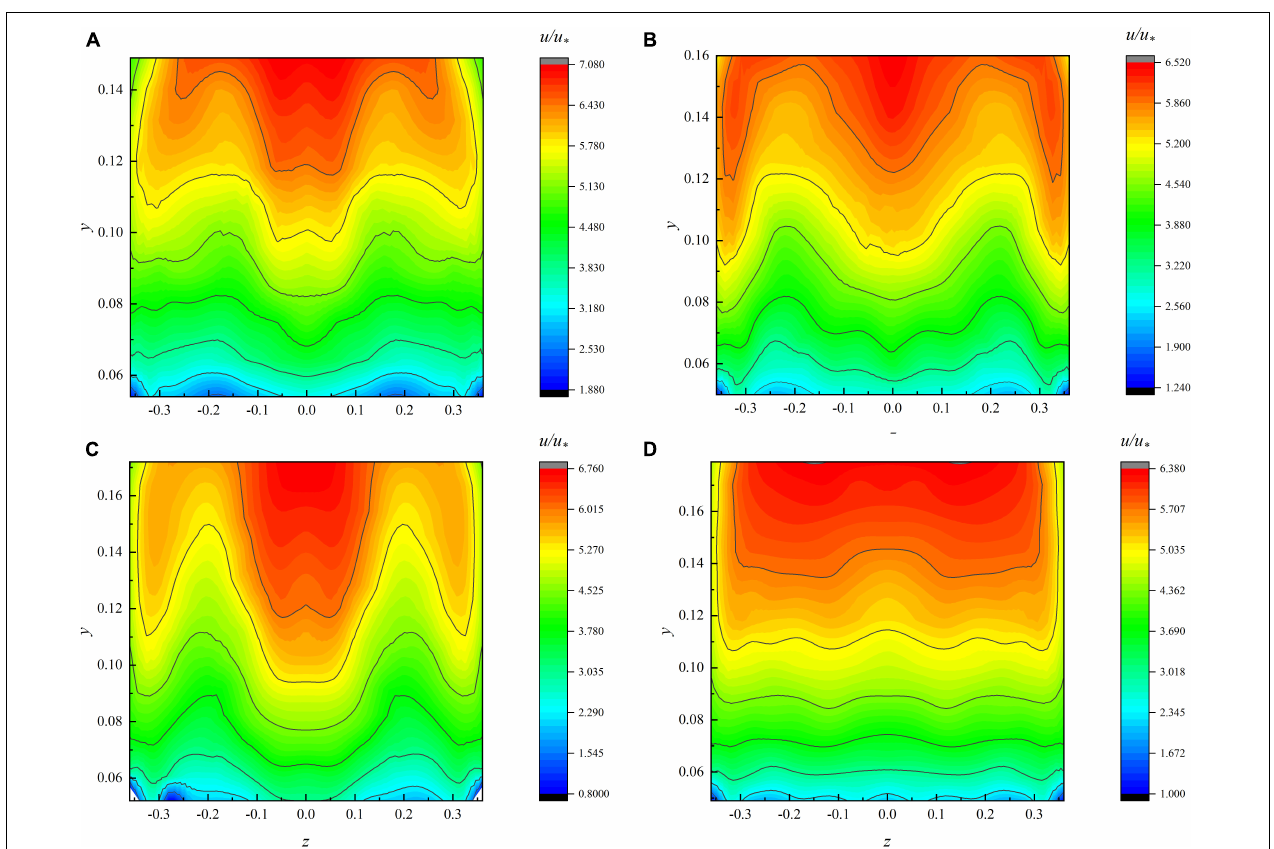
FIGURE 4 | Flow field contour. (A) 90 m 3 /h, (B) 100 m 3 /h, (C) 110 m 3 /h, (D) 120 m 3